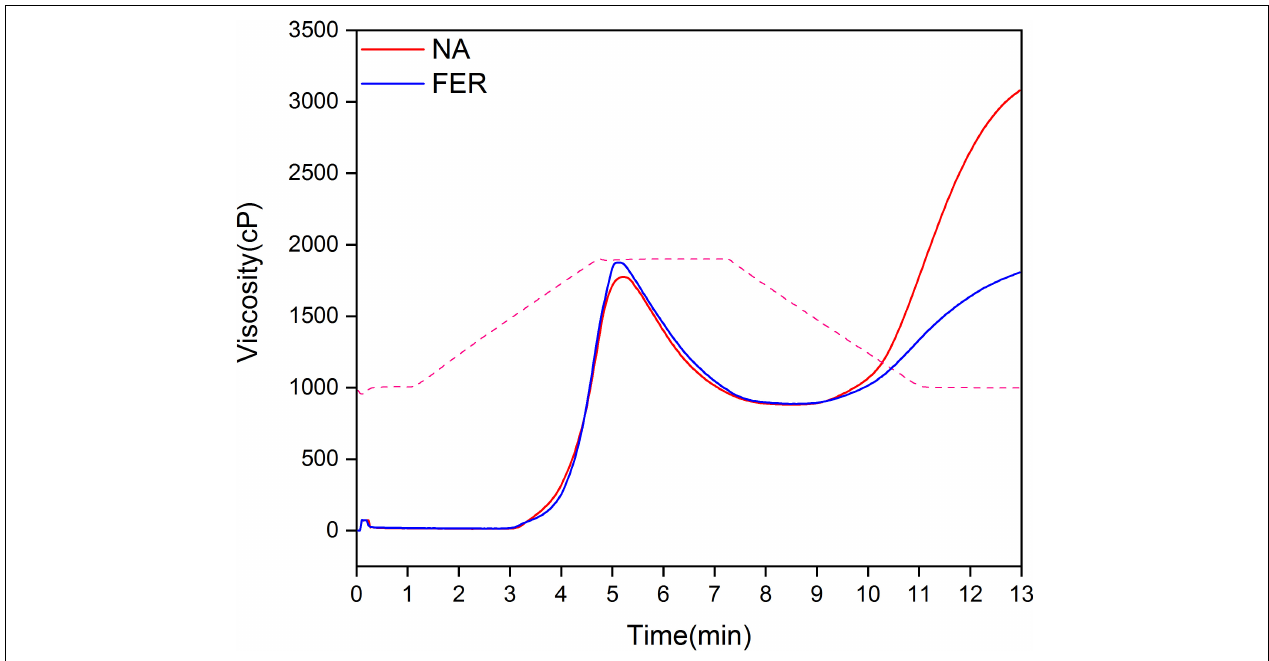
FIGURE 8 | Pasting profile of broomcorn millet flour. Pasting profile of natural rice flour and fermented rice flour. Red and blue solid lines represent the viscosity (cP) profile of natural sample and fermented sample, respectively. The dotted line is the temperature ( ◦ C). TABLE 3 | Pasting properties of broomcorn millet.